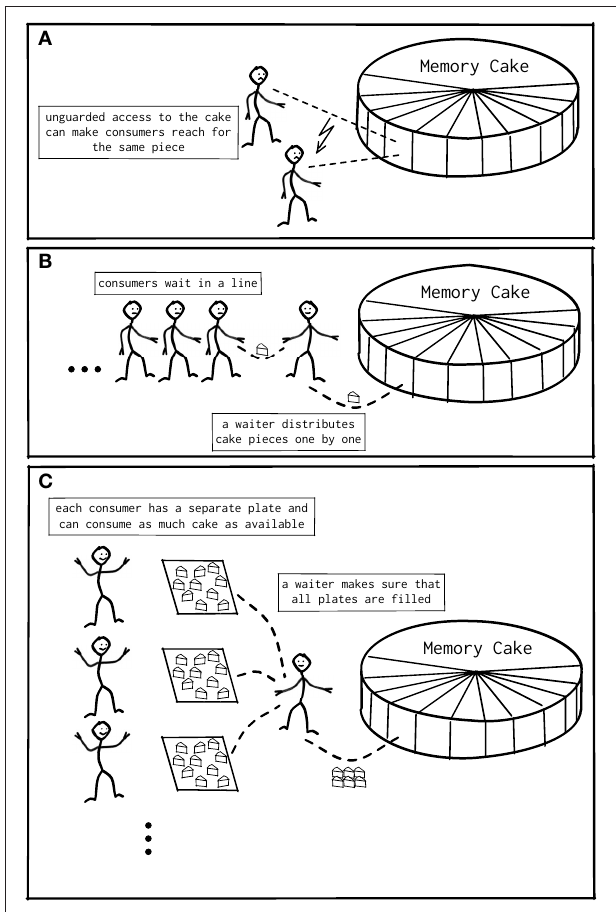
FIGURE 4 | Shared memory access patterns. (A) Unguarded access to memory in multi-threaded programs can result in assigning the same memory region to different threads, causing unintentional overrides by the threads. (B) The trivial solution is to implement a guard or barrier managing all access to memory. This results in a bottleneck in case many threads access memory in rapid succession. (C) Modern memory managers implement thread-local regions, from which a thread can interact with memory: Interaction with the global memory becomes necessary only if the region is empty or overcrowded, and only this interaction needs to be guarded. This removes the bottleneck for most